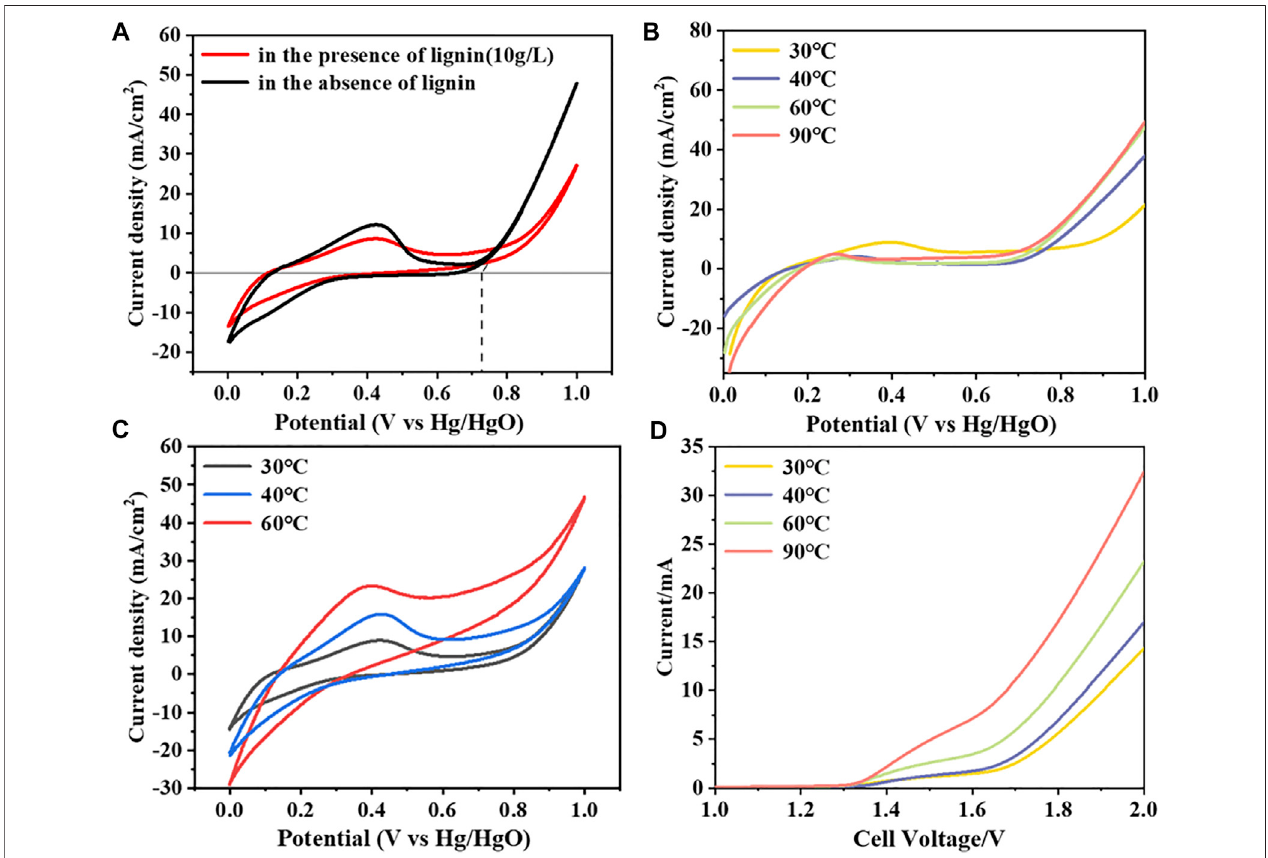
FIGURE 2 | The electrochemical performance of Ti/PbO 2 as the anode in AWE and LAWE: (A) CV curves of Ti/PbO 2 at 30 ° C, with a scan rate of 20 mV/s; (B) LSV curves at different temperatures in AWE, with a scan rate of 5 mV/s; (C) CV curves of lignin added at different temperatures, with a scan rate of 20 mV/s; (D) Two- electrode LSV curves at different temperatures, with a scan rate of 5 mV/s. Solution: 1 mol/L